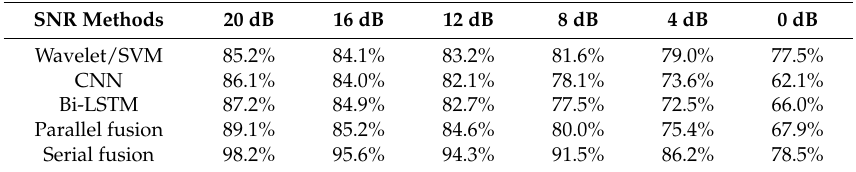
Table 4. Classification accuracy of different methods with signal-to-noise ratio (SNR) from 0 to 20dB.